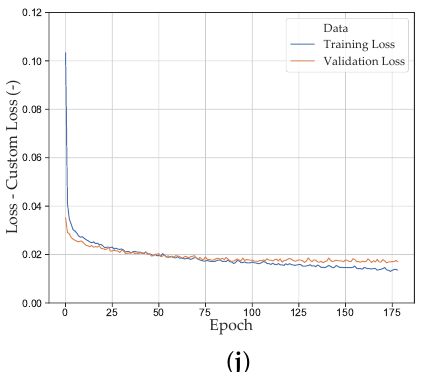
Figure A5. NN_Run learning curves for the training and validation dataset: ( a ) NN_Run_1; ( b )